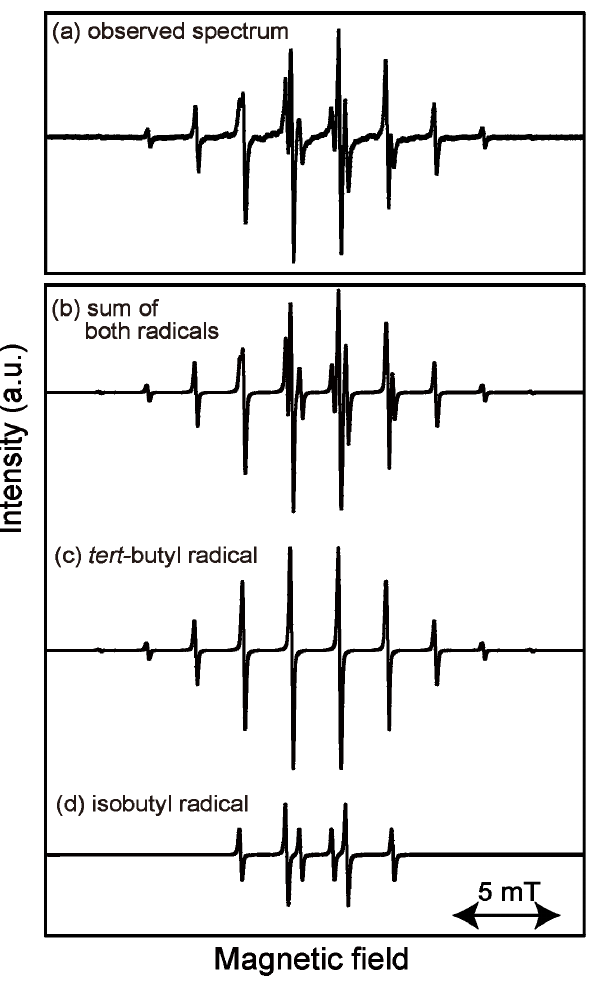
Figure 2. ( a ) Observed ESR spectrum of radicals induced in the γ -ray-irradiated isobutane hydrate with D O at 270 K (before annealing); ( b – d ) Calculated ESR spectra of tert -butyl 2 radical in ( c ), isobutyl radical in ( d ), and their sum in ( b ). In this case, the molar ratio of tert -butyl radical to isobutyl radical is approximately